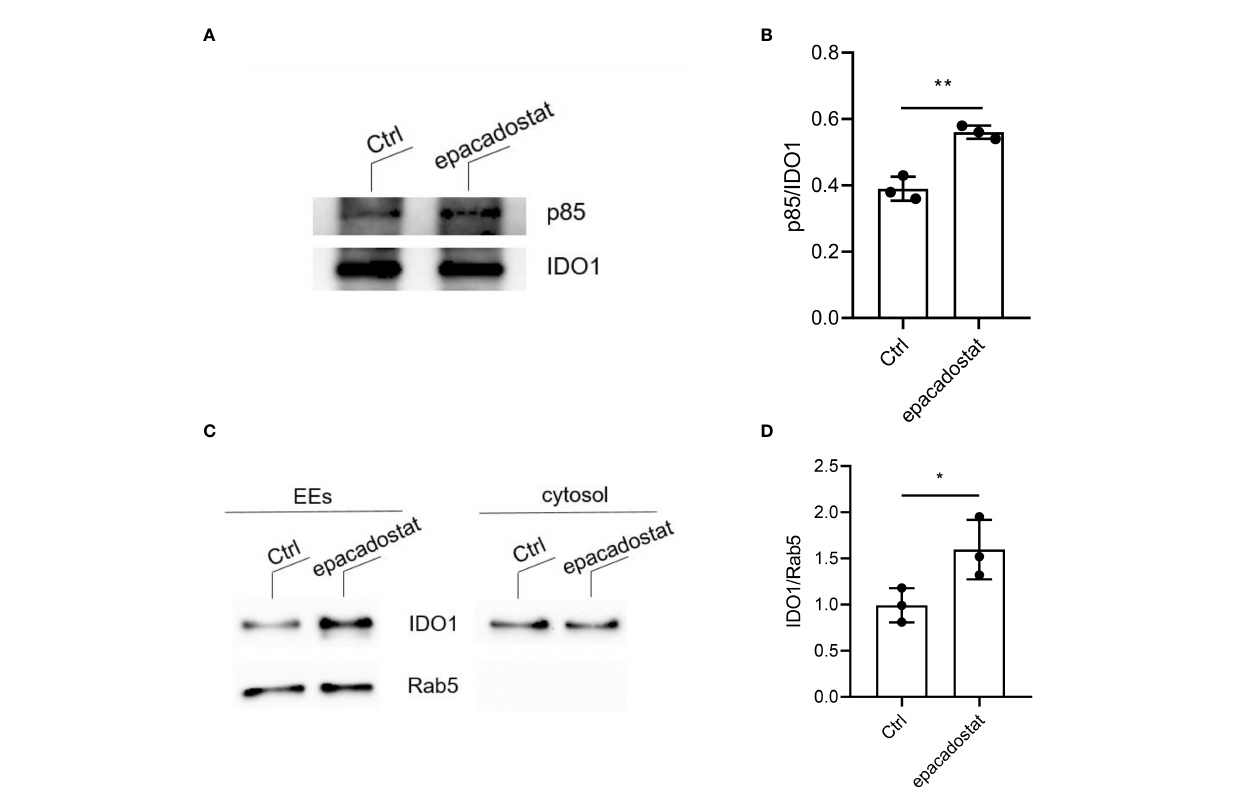
FIGURE 3 Epacadostat favors the IDO1 signaling localization in tumor transfectants. (A) Immunoprecipitation of IDO1 from WCL of P1.HTR IDO1 transfectants treated with epacadostat (1 m M) or the vehicle alone (Ctrl), and detection of IDO1 or its molecular partner p85 PI3K by sequential immunoblotting with speci fi c antibodies. One experiment representative of three is shown. (B) Quantitative analysis of three independent immunoblot experiments, one of which represented in (A) . Data ± SD represent the ratio of co-immunoprecipitated p85 protein over immunoprecipitated IDO1. (C) Immunoblot analysis of endosomes (EEs) and cytosol isolated from epacadostat-treated P1.IDO1 cells. Cells incubated with the vehicle DMSO were used as a control (Ctrl). One experiment representative of three is shown. (D) Quantitative analysis of three independent immunoblot experiments, one of which represented in (C) . IDO1:Rab5 ratio was calculated by densitometric quanti fi cation of the speci fi c bands detected in three independent experiments (mean ± S.D.). *p< 0.05 **p< 0.01 (Paired Student ’ s t-